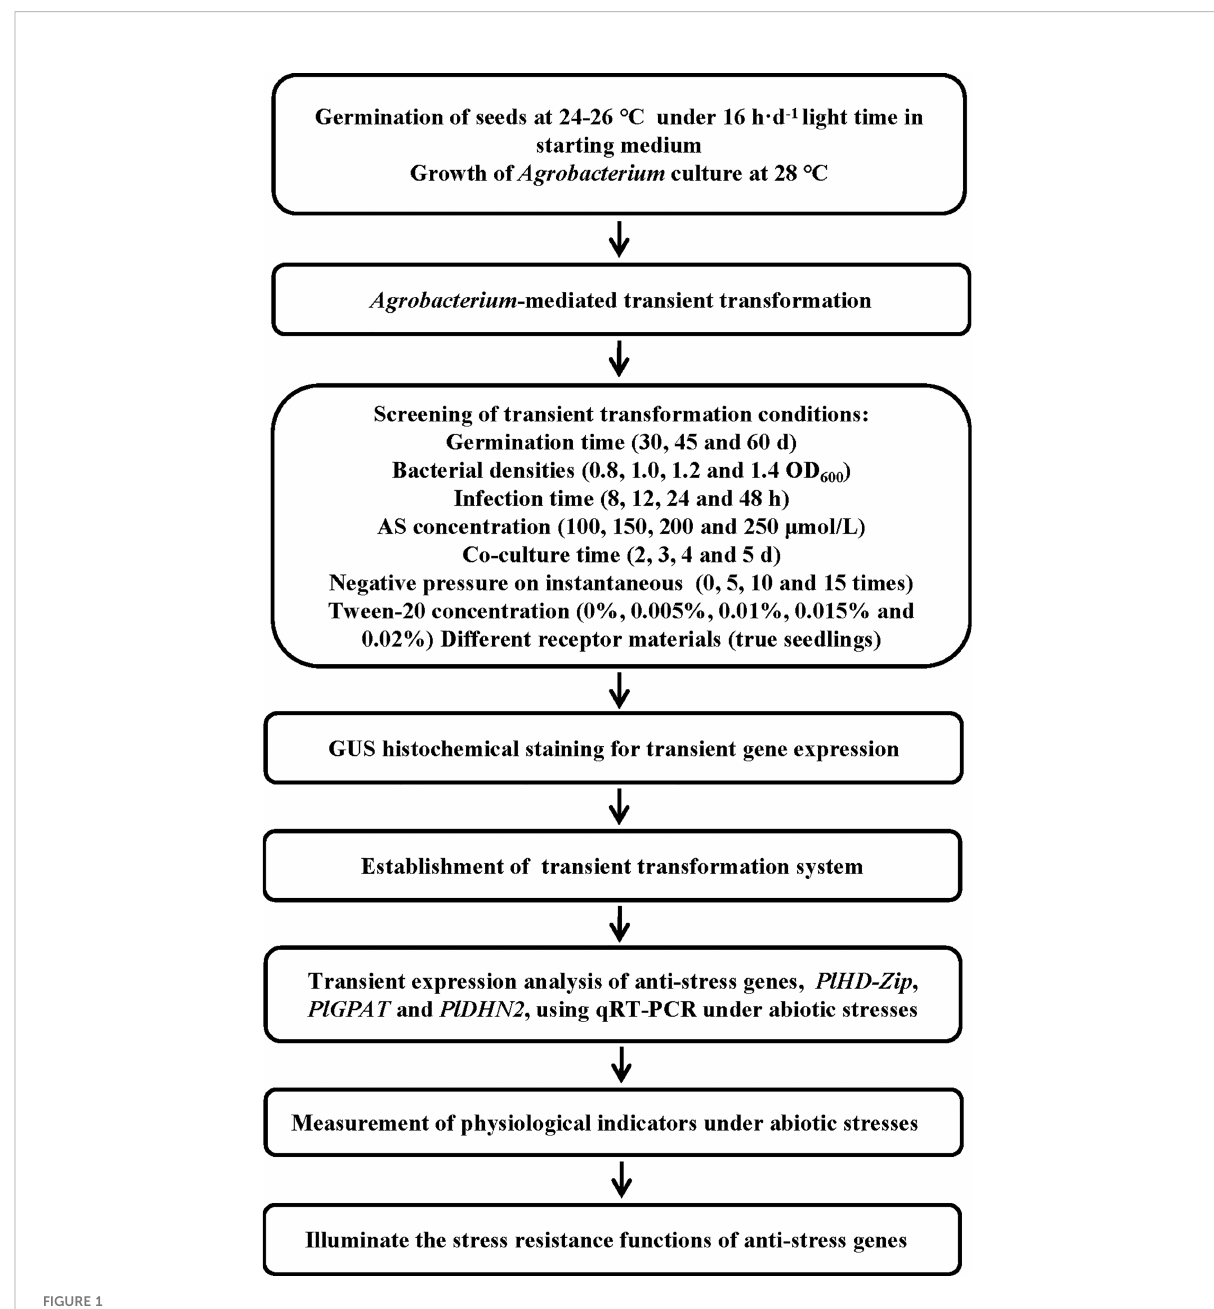
FIGURE 1 Flow chart of Agrobacterium -mediated transient transformation system for the development of transgenic P. lacti fl ora